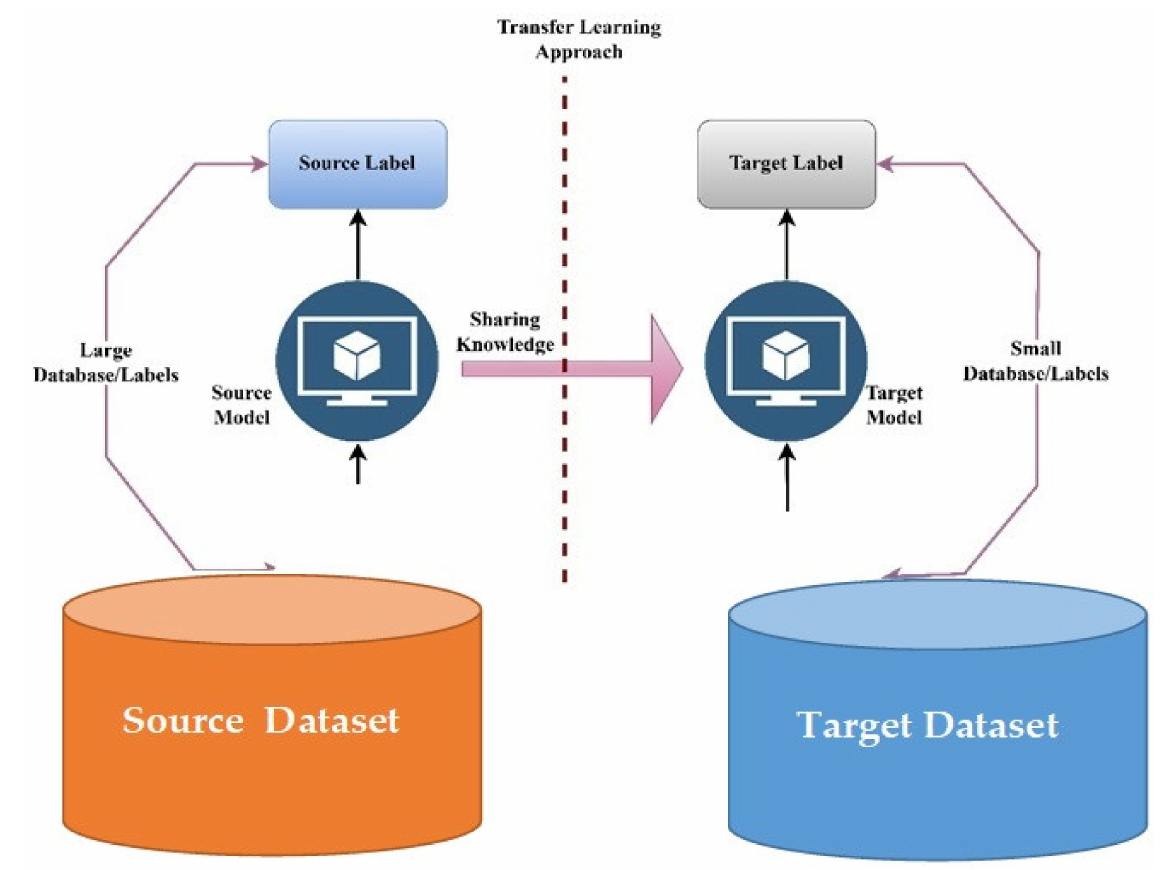
Figure 2. Transfer learning